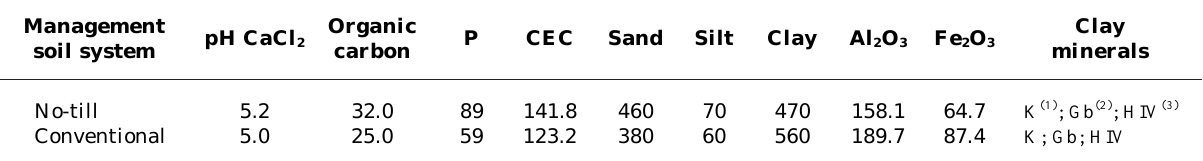
Table 1. Chemical characteristics, physical and mineralogical properties of a Brazilian Rhodic Oxisol collected from no-till or conventional management soil system Management soil